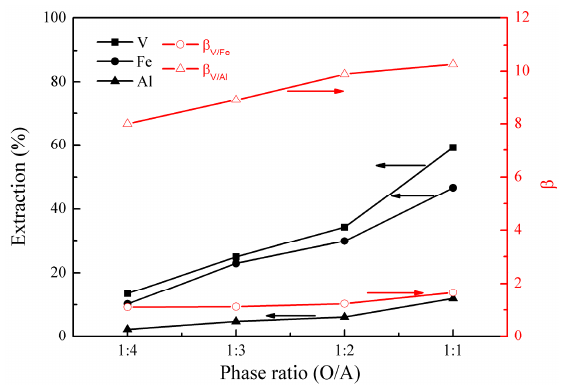
Figure 4. Effect of phase ratio (O/A) on the extraction percentages of V (IV), Fe, and Al, as well as on the separation factors β V/Fe and β V/Al .